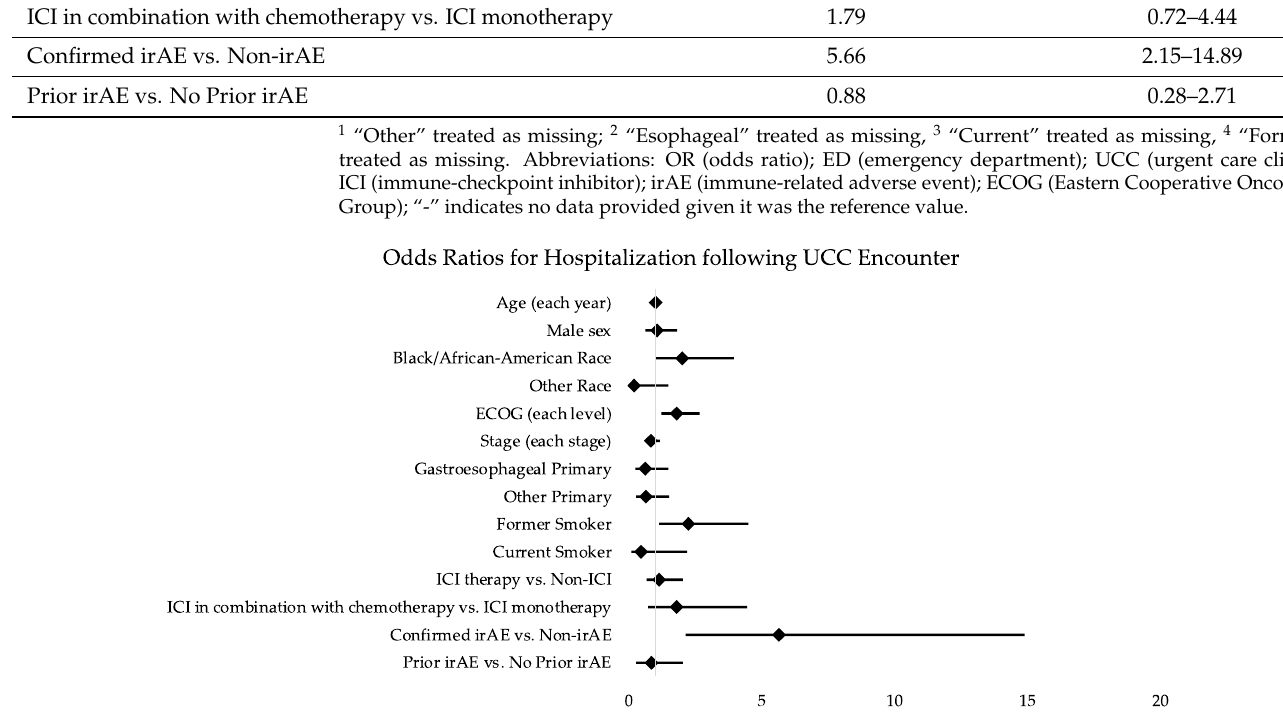
Table 2. Associations between clinical features and hospitalization following UCC encounters.